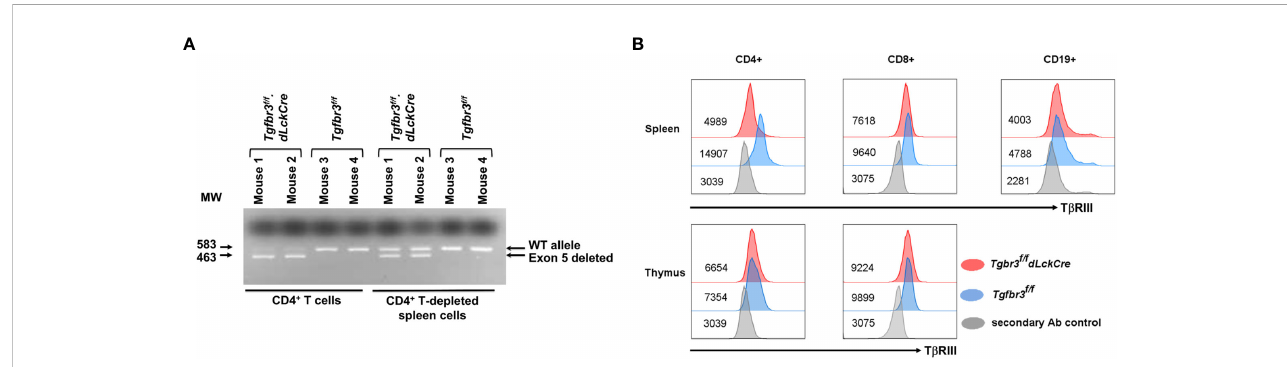
FIGURE 1 Inactivation of T b RIII in peripheral CD4 T cells in Tgfbr3 fl / fl .dLcKCre mice. The T b RIII deletion was assessed by PCR and by fl ow cytometry on CD4 + T cells. (A) Representative electrophoresis gel for presence of Tgfbr3 5 (583 bp) or its deletion (463 bp) in CD4 + cells or CD4-depleted spleen cells from Tgfbr3 fl / fl .dLcKCre and Tgfbr3 fl / fl control mice. (B) Representative histograms for T b RIII expression on CD4 + , CD8 + , and CD19 + cells from spleen and thymus of Tgfbr3 fl / fl .dLcKCre (red) and Tgfbr3 fl / fl (blue) control mice, including the secondary antibody control (gray) for each population, median expression is represented next each